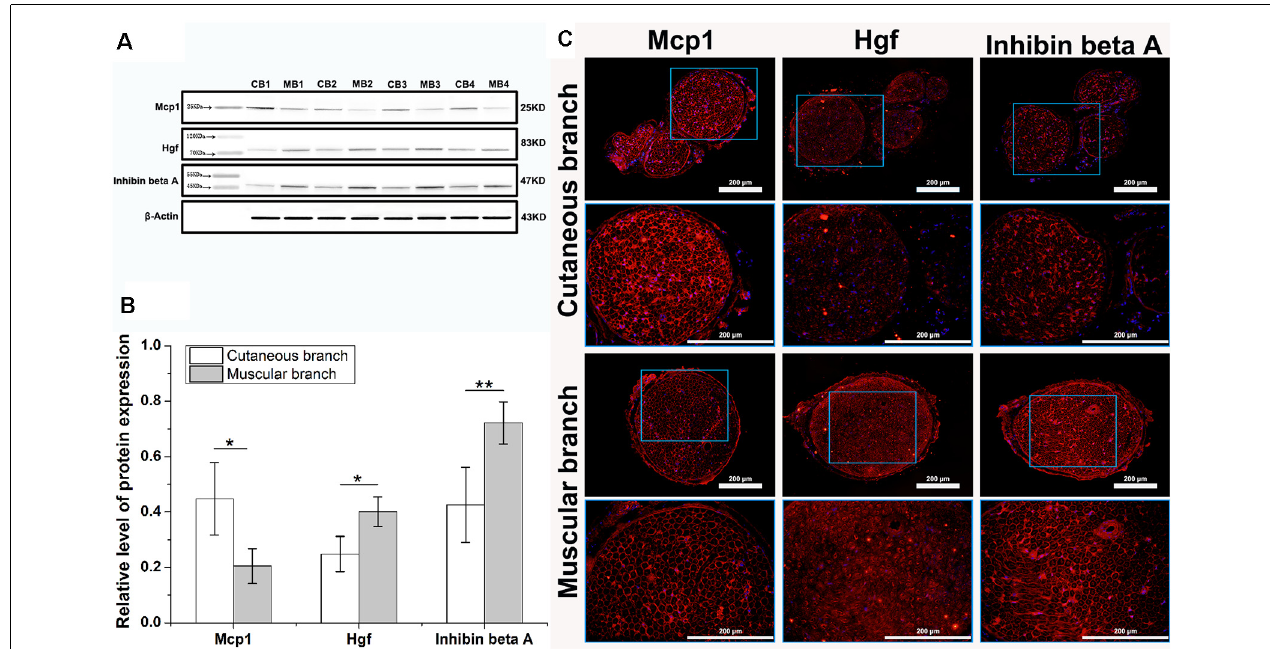
FIGURE 4 | Western blot and immunofluorescence analysis of key differentially expressed proteins. (A) The western blot shows three specific protein bands, β -Actin served as an internal control. The Mcp1 protein was upregulated in cutaneous branch (CB), Hgf and Inhibin beta A proteins were upregulated in the muscular branch (MB). (B) The relative level of three key proteins expression, data are shown as means ± SD from four independent experiments, statistically analyzed by independent sample t -test. * p < 0.05; ** p < 0.01. (C) The immunofluorescence image of three key differentially expressed proteins, each key protein (red) and nucleus (blue) are shown in the cutaneous branch and muscular branch of the femoral nerve. The interest area in the blue frame is enlarged in the following